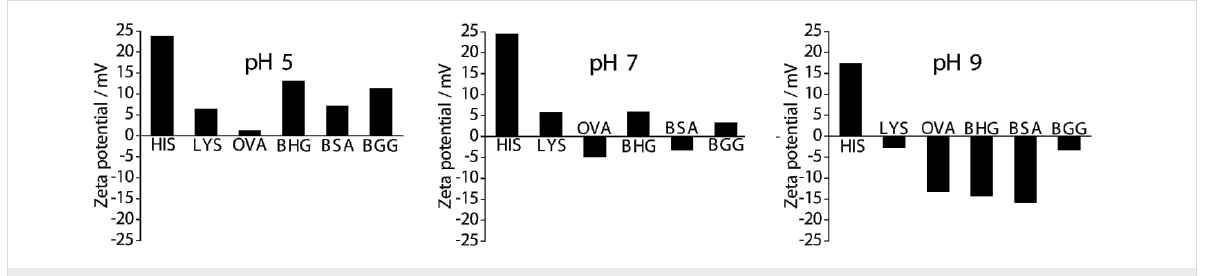
Figure 5: Zeta potential of AuNPs prepared using different proteins at pH 5, 7 and 9.